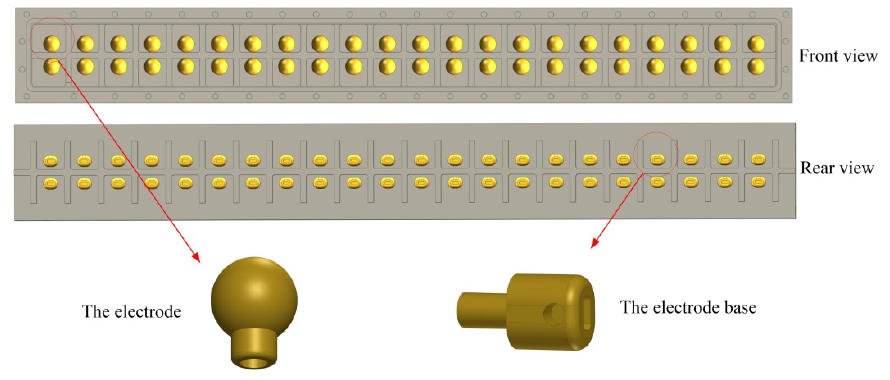
Figure 4. The assembly diagram of the gas gap switches.